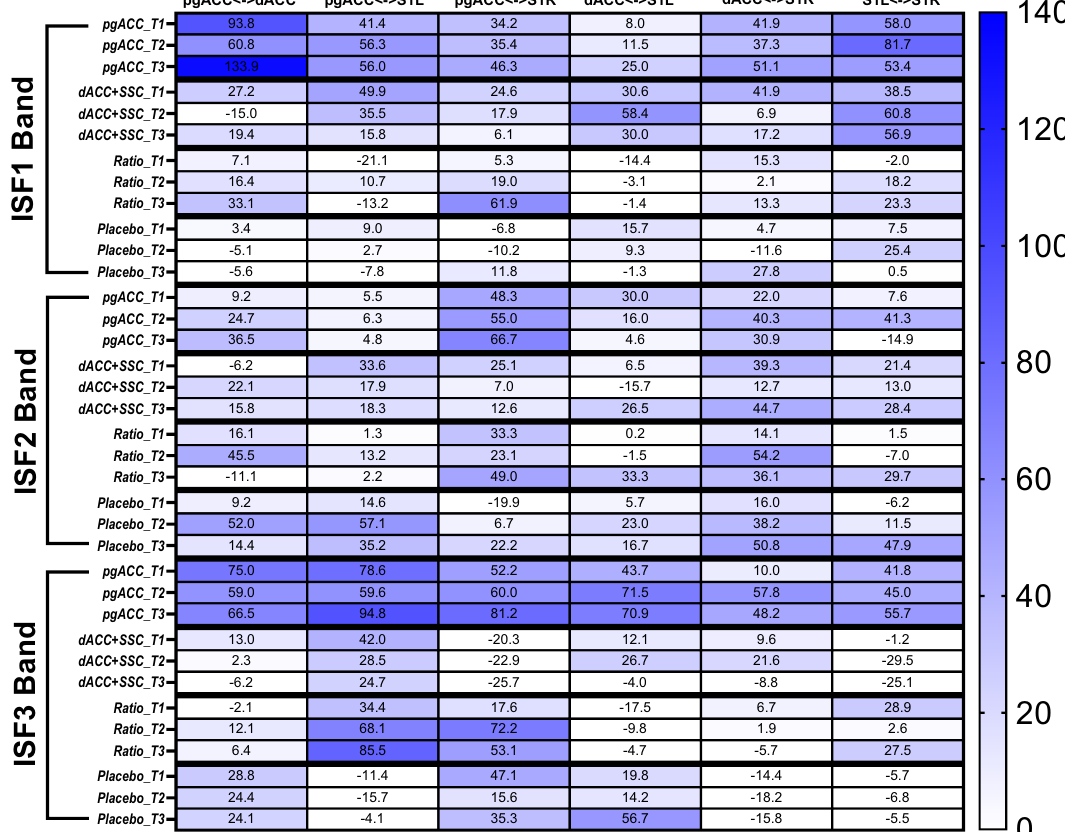
Figure 6. Heatmaps for mean percentage change to baseline in functional connectivity in the infraslow frequency bands. pgACC: pregenual anterior cingulate cortex, dACC: dorsal anterior cingulate cortex, SSC: primary somatosensory cortex, ISF1: Infraslow frequency- low band (0.01–0.04 Hz), ISF2: Infraslow frequency- mid band (0.05–0.07 Hz), ISF3: Infraslow frequency- high band (0.08–0.10 Hz), S1L: Primary Somatosensory cortex left, S1R: Primary Somatosensory cortex right, T0: baseline, T1: immediately post-treatment, T2: 1 week follow up, T3: 1 month follow up, <->: functional Connectivity between regions. Higher values represent increase in the functional connectivity compared to